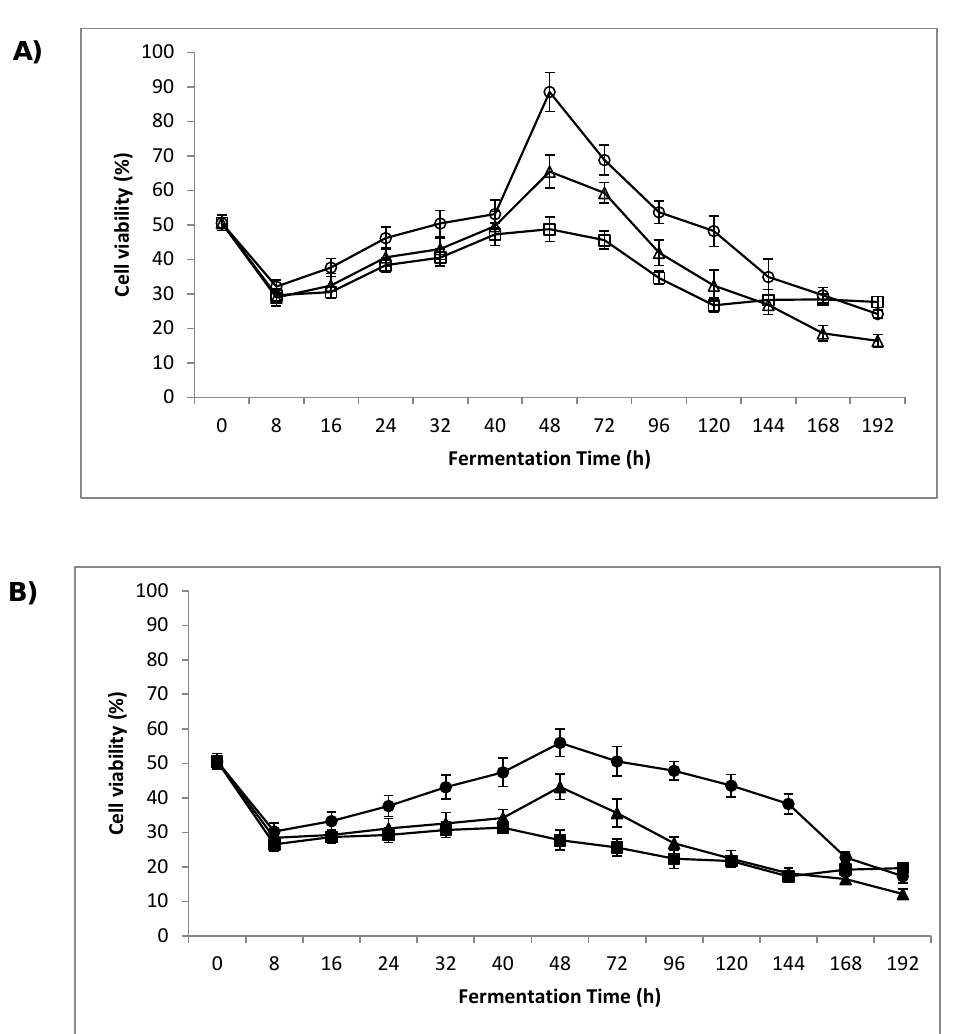
Figure 7. ( A ) Yeast cell viability (%) of non-NaCl-stressed cells during various fermentation times (h) with three different media containing 200, 300, or 400 g/L glucose after cell treatment with Glucanex 200G lytic enzyme ( n = 3 replications for each time and error bars represent standard deviation of the average value of all replications with each range of fermentation time); ( B ) Yeast cell viability (%) of NaCl-stressed cells during various fermentation times (h) with three different media containing 200, 300, or 400 g/L glucose after cell treatment with Glucanex 200G lytic enzyme ( n = 3 replications for each time and error bars represent standard deviation of the average value of all replications with each range of fermentation time) ( ): (200 g/L glucose, 0% NaCl), ( ∆ ): (300 g/L glucose, 0% NaCl), (cid:35) ( (cid:3) ): (400 g/L glucose, 0% NaCl), ( ): (200 g/L glucose, 6% NaCl), ( (cid:78) ): (300 g/L glucose, 6% NaCl), ( (cid:4) ): (400 g/L glucose, 6%